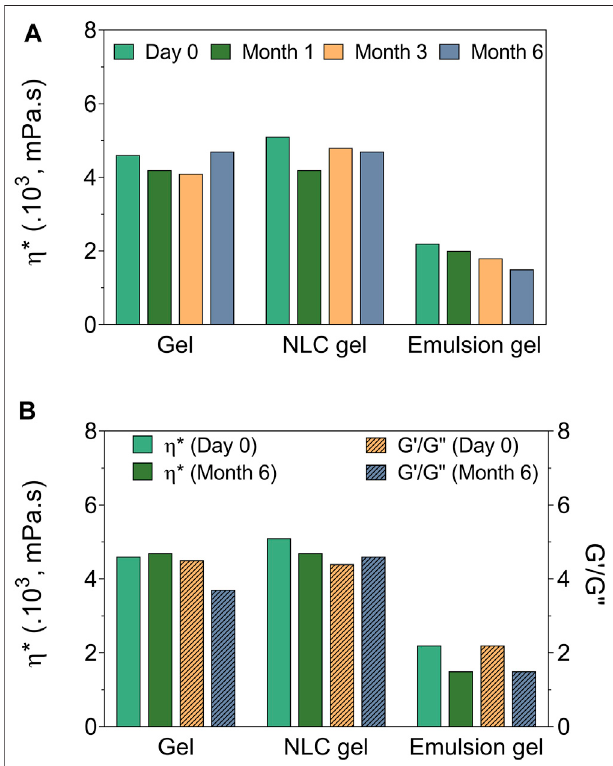
FIGURE 6 | Viscosity and mechanical properties, measured over 6 months, for the gel (2% HPMC), NLCs + gel (2% GRL +5% ICA), and emulsion + gel (2% GRL +5% ICA). (A) Apparent viscosity, as a function of time. (B) Apparent viscosity ( ŋ *) and G ’ /G ″ ratio on day 0 and after 6